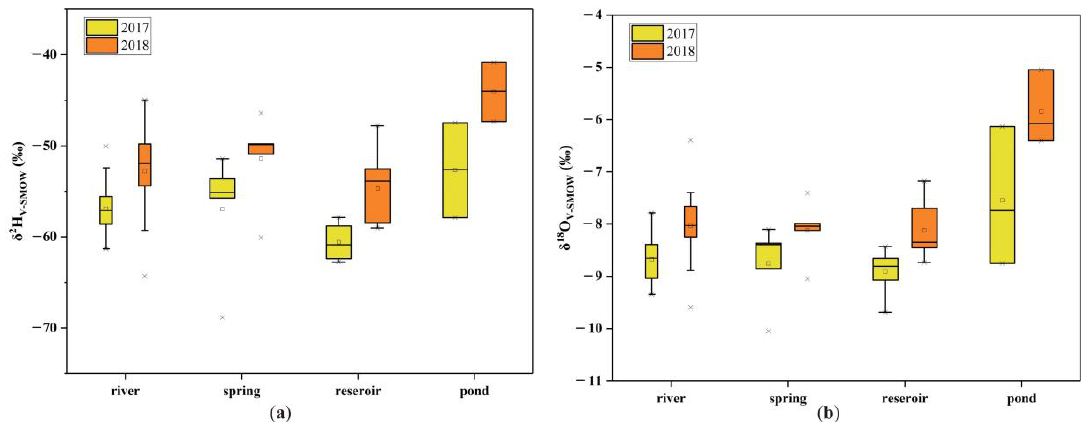
Figure 2. Box diagrams of ( a ) δ 2 H and ( b ) δ 18 O values in di ff erent water bodies. Table 1. Locations and isotopic compositions of river, spring, reservoir, and pond water samples. Water types No.